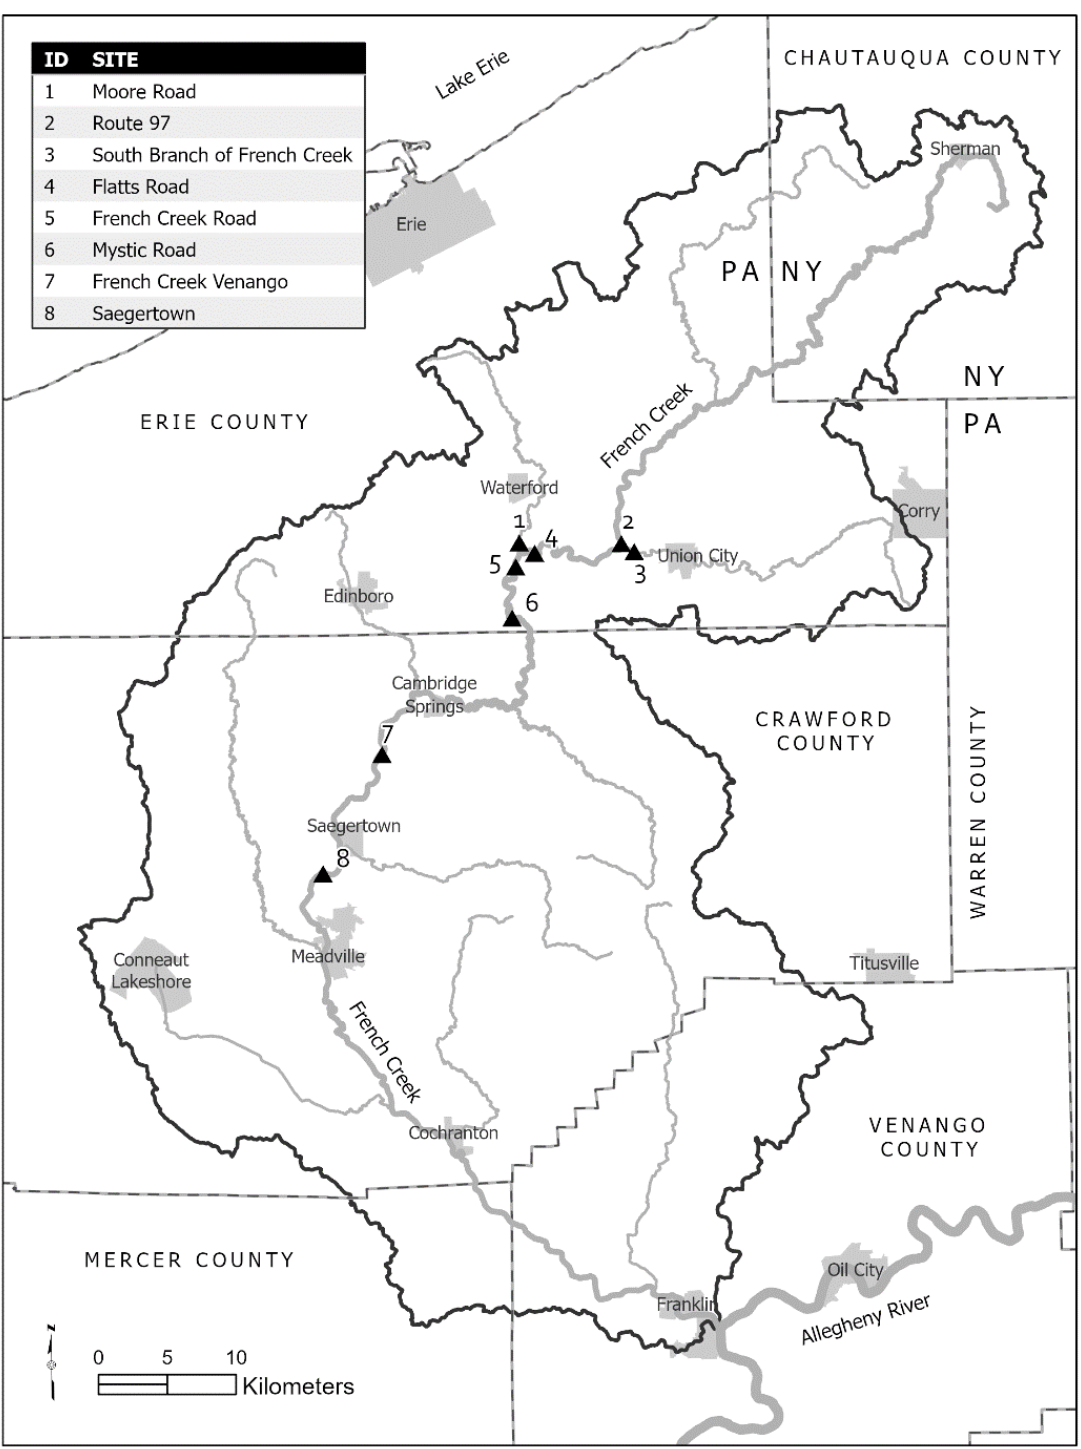
Figure 1. Map of the French Creek Watershed in New York and Pennsylvania, and the stream locations where native freshwater mussels were sampled.